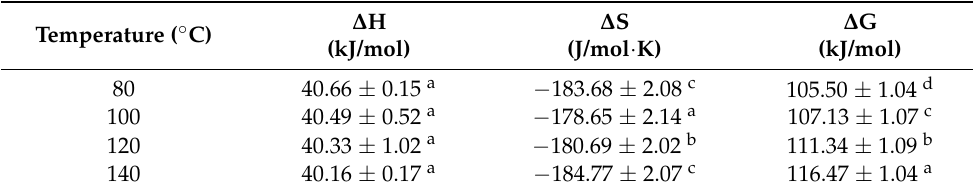
Table 6. Thermodynamic parameters obtained for antioxidant activity degradation in red grape skin